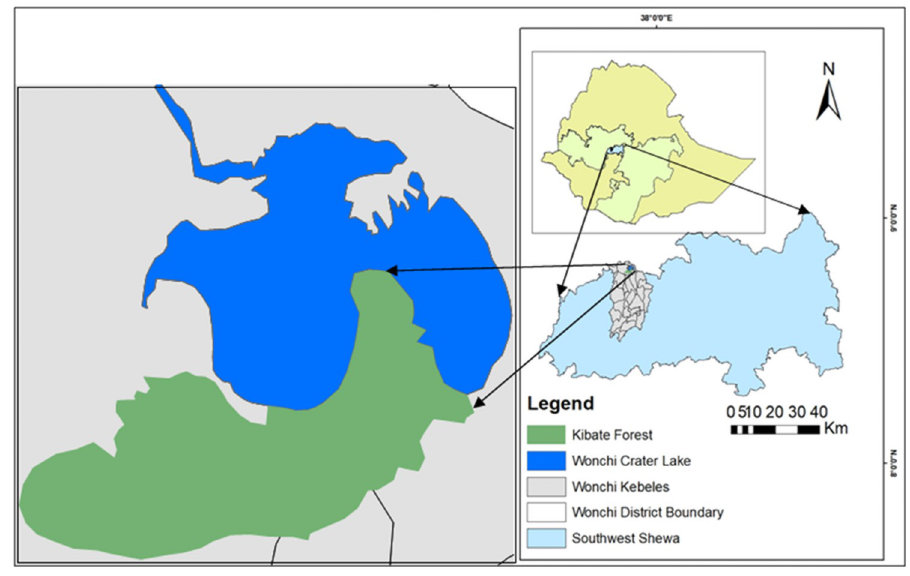
Fig 1. Map of Ethiopia showing the location of the study site. (Source: Adapted from Meragiaw et al. [49]).